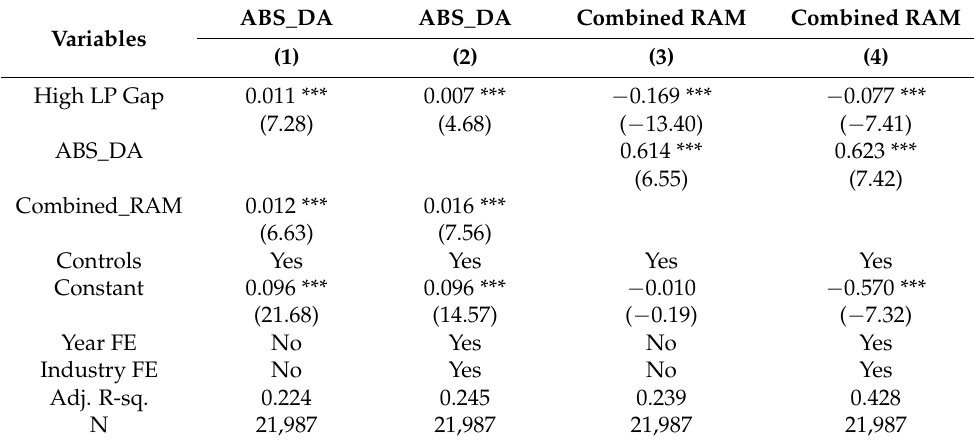
Table 5. Earnings management and level of labor productivity gap. (*** indicates level of significance at 99%